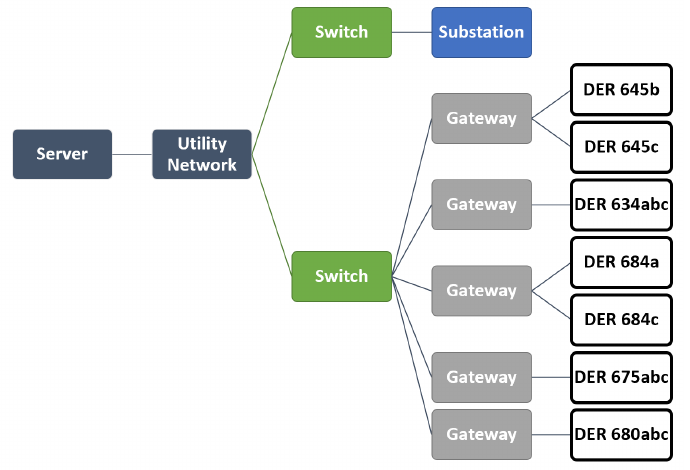
Figure 2. Representative network structure for IEEE 13-bus test system with extensive distributed energy resource (DER) usage, derived from [11].